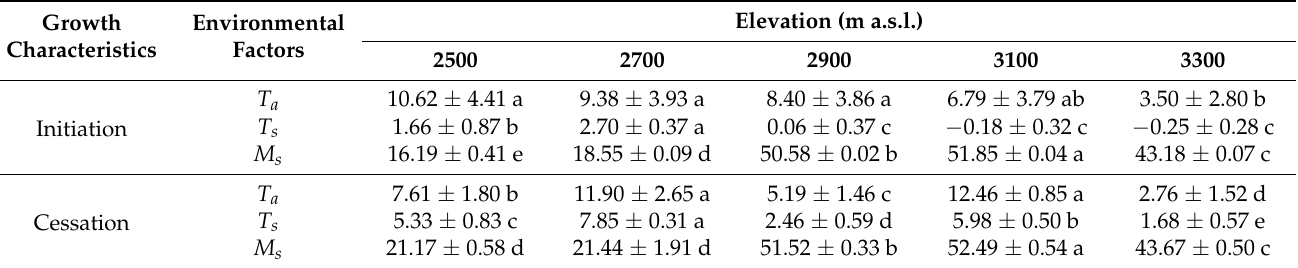
Table 4. Thresholds of environmental factors (mean air temperature ( T a ), mean soil temperature ( T s ) and volumetric soil moisture content ( M s ) of the 0 to 60 cm soil layer) for seasonal patterns of stem growth of Qinghai spruce trees in the Pailugou